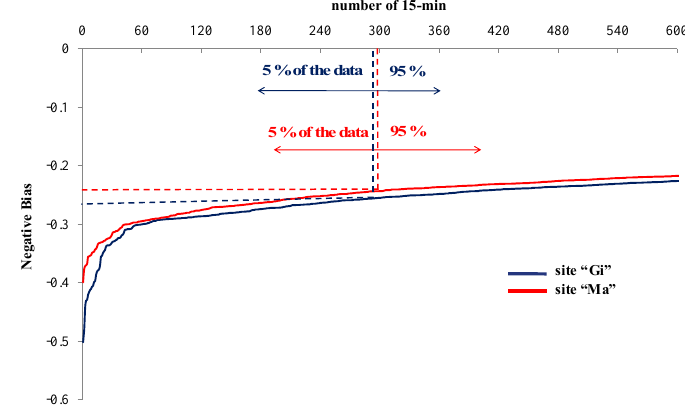
Figure 9. Zoom of the duration curves of negative bias for the solar irradiance estimated data with respect to measurements for the year 2012 at the sites “Gi” and “Ma”.